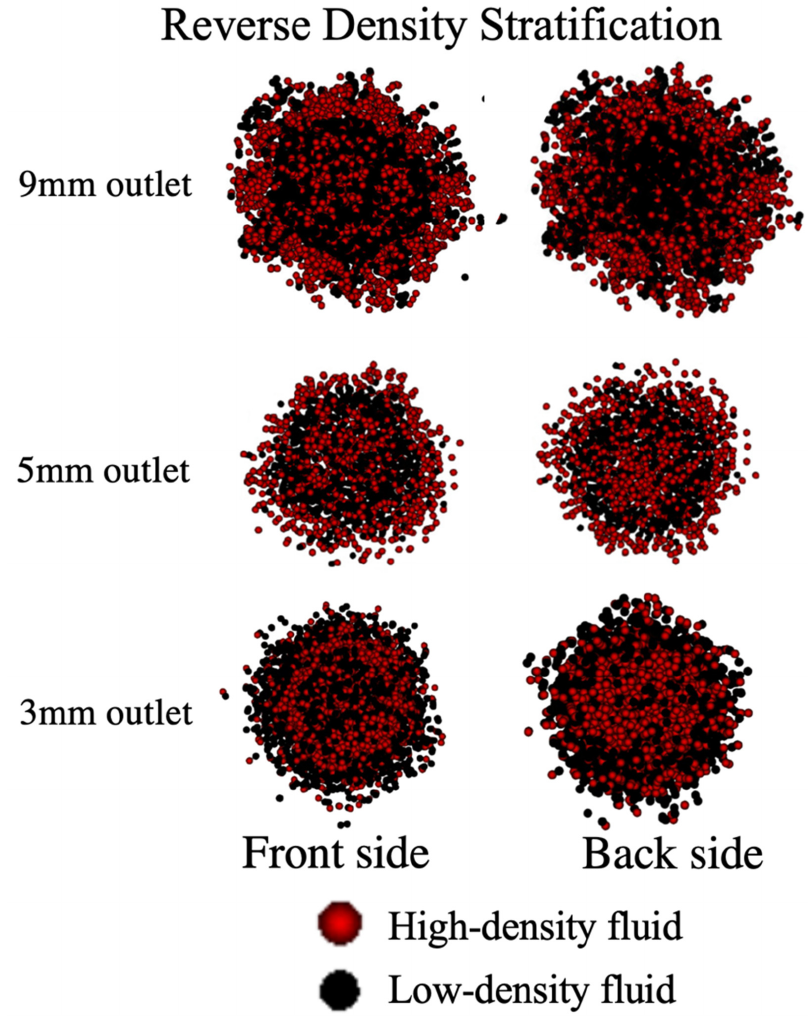
Figure 13. Summary on the material distribution after the solidification with different outlet in the case of the reverse density stratification.